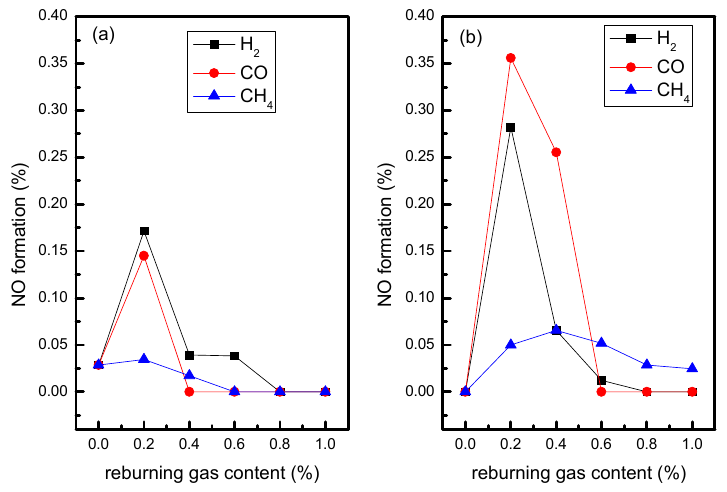
O decomposition with circulating ash as bed material 2 O/N , 900 °C). 2 2